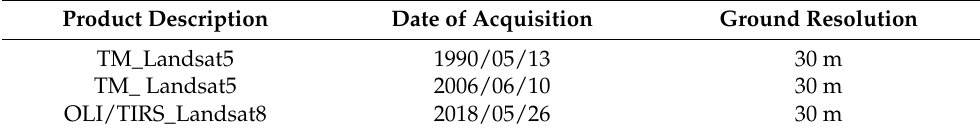
Table 1. Landsat products.